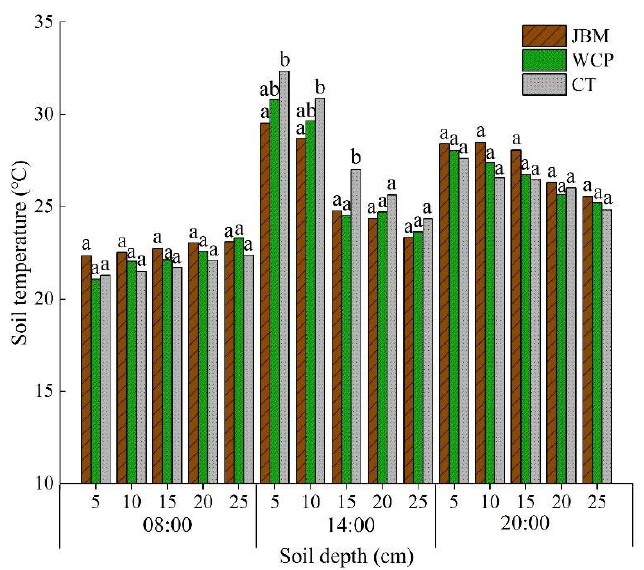
Figure 3. Diurnal variations in soil temperature in the 0–25 cm soil layer at various depths under different mulching measures. At the same time, different lowercase letters at the same depth indicate significant differences in soil temperature for mulching treatments according to Tukey’s test ( p < 0.05).